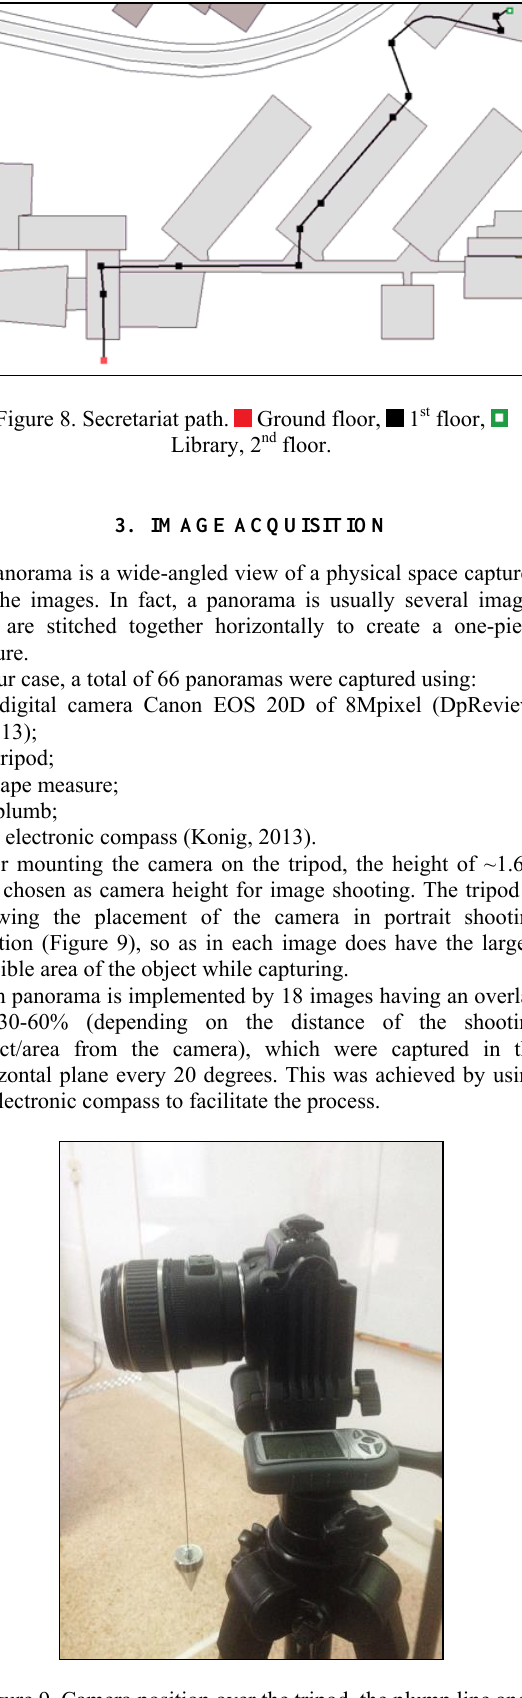
Figure 12. The final